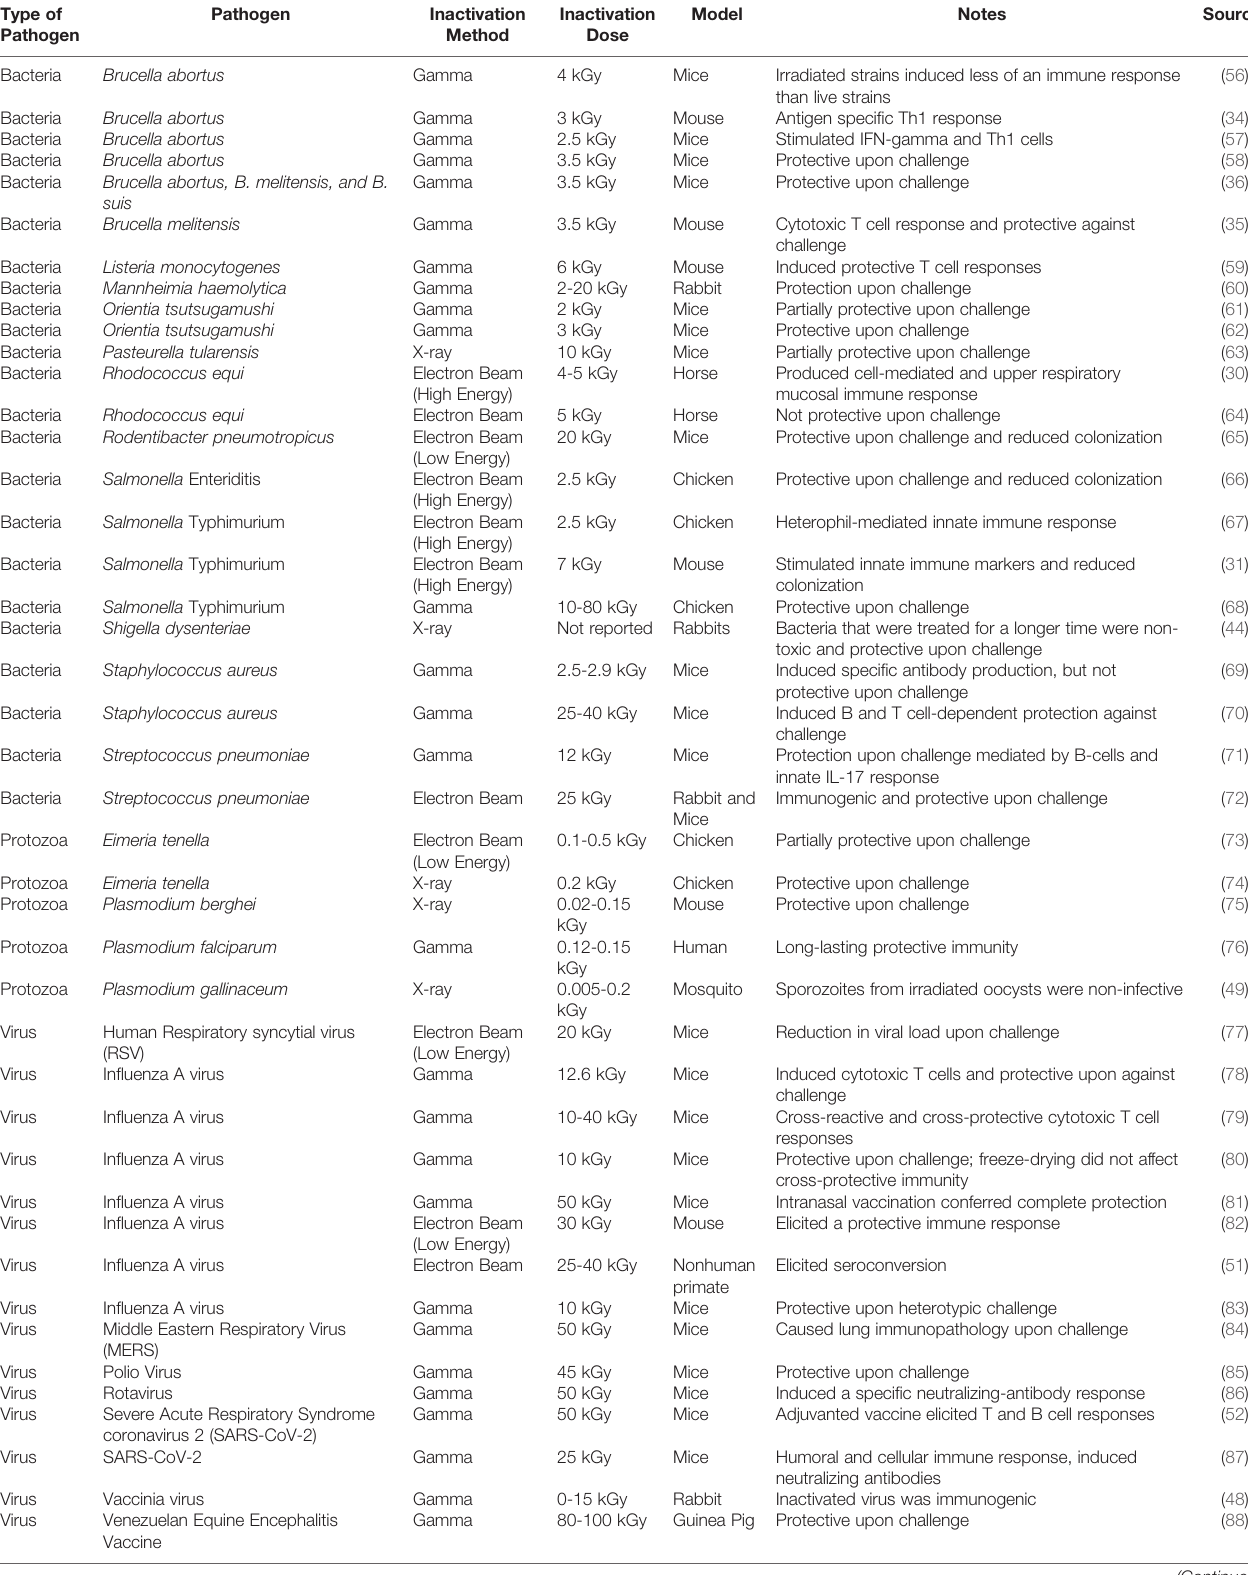
TABLE 2 | List of radio-vaccines against bacterial, viral, and protozoan pathogens. Type of